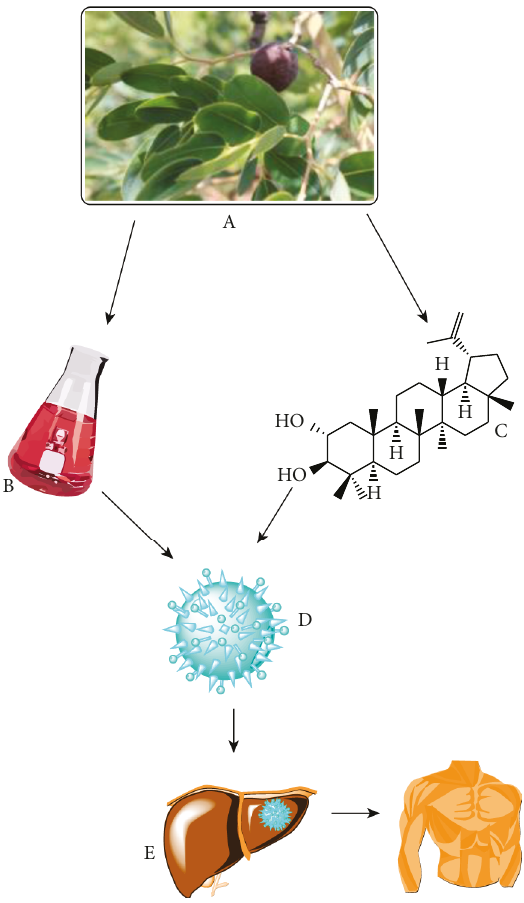
Figure 5: Schematic presentation of Detarium microcarpum to target cancer cells. A � Detarium microcarpum ; B � crude extract; C � pure compound; D � cancer cell; E � organ with cancer cell; and F � treated